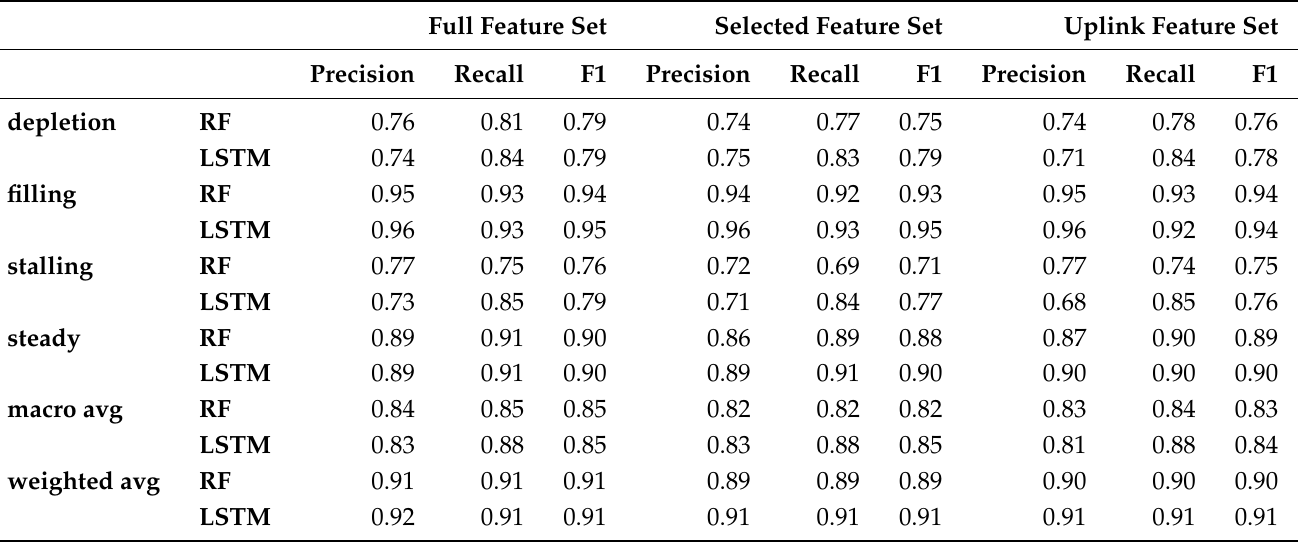
Table 14. Phase prediction